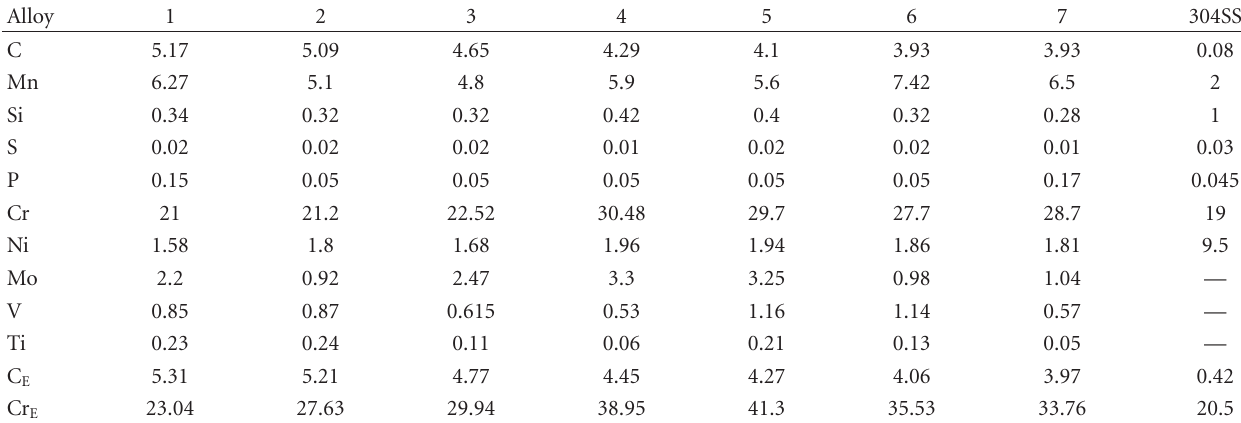
Table 1: Chemical composition of castings